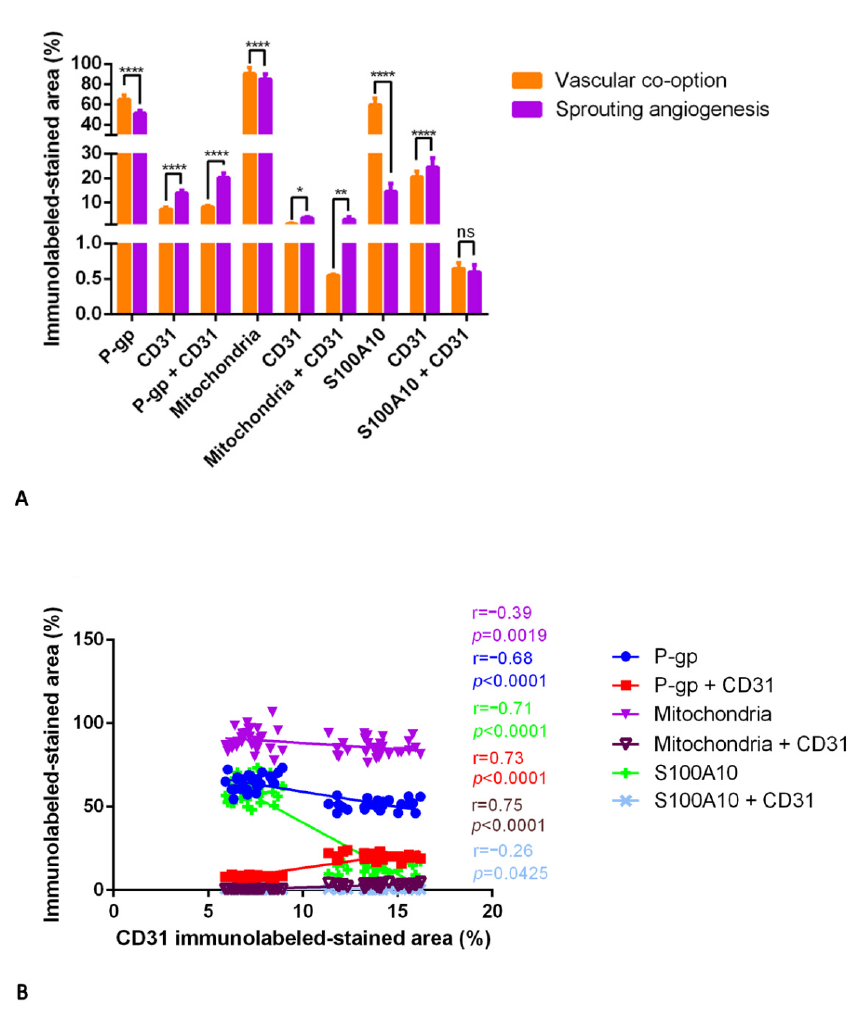
Figure 13. P-gp/CD31, mitochondria/CD31, and S100A10/CD31 quantification in IDH-WT glioblas- toma. P-gp, mitochondria, S100A10, and CD31 were evaluated by immunohistochemistry and were estimated as a percentage of digital quantification within the same spatial ROIs on IDH-WT glioblastoma serial sections using the colocalization algorithm. P-gp, mitochondria, and S100A10 are significantly overexpressed where vascular co-option occurs versus sprouting angiogenesis ( A ). Where sprouting angiogenesis occurs, CD31, P-gp + CD31, and mitochondria + CD31 are overex- pressed versus vascular co-option and progressively increased from normal to intratumoral areas. No significant differences are noted in S100A10 + CD31 expression ( A ). Linear regression analysis ( B ) shows a positive and very strong statistical correlation between the CD31 expression and mito- chondria + CD31 co-expression. Moderate is the correlation of CD31 expression with P-gp or S100A10 expression or with P-gp + CD31 co-expression ( B ). Fair is the CD31 correlation with mitochondria or S100A10 + CD31 ( B ) [For P-gp: Y = − 1.815*X + 77.15; for P-gp + CD31: Y = 1.636*X − 3.036; for mitochondria: Y = − 0.7160*X + 95.28; for mitochondria + CD31: Y = 0.3668*X − 2.002; for S100A10: Y = − 6.147*X + 102.0; for S100A10 + CD31: Y = − 0.007386*X + 0.6995]. Data are reported as mean ± SD, and the Tukey’s post hoc test was used to compare all groups after two-way ANOVA. We did not quantify the peritumoral area in which there is vessel co-option with re- spect to the intratumoral one, but 28/30 glioblastomas showed co-opted blood vessels in N = 30. ns, not significative; * p < 0.05; ** p < 0.01; **** p <